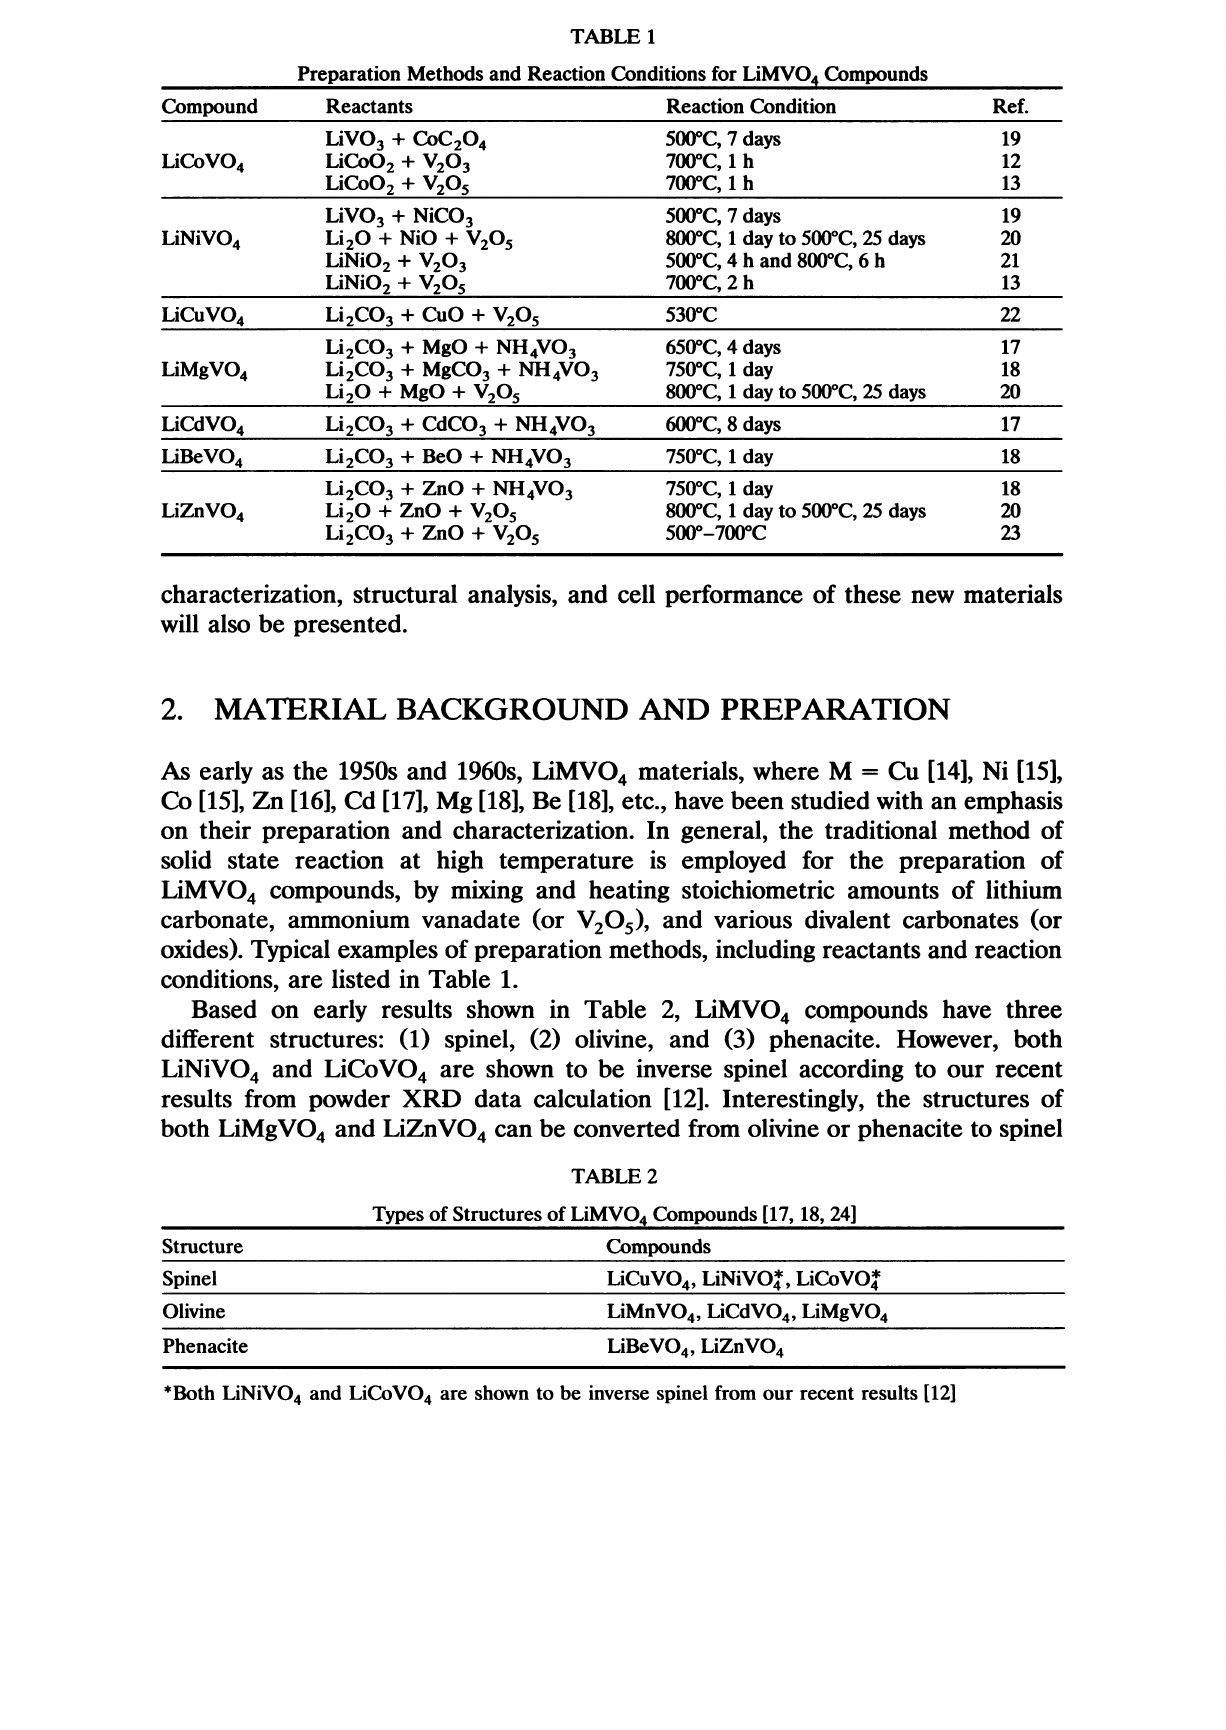
Preparation Methods and Reaction Conditions for LiMVO 4 Compounds Reactants Reaction Condition Ref.